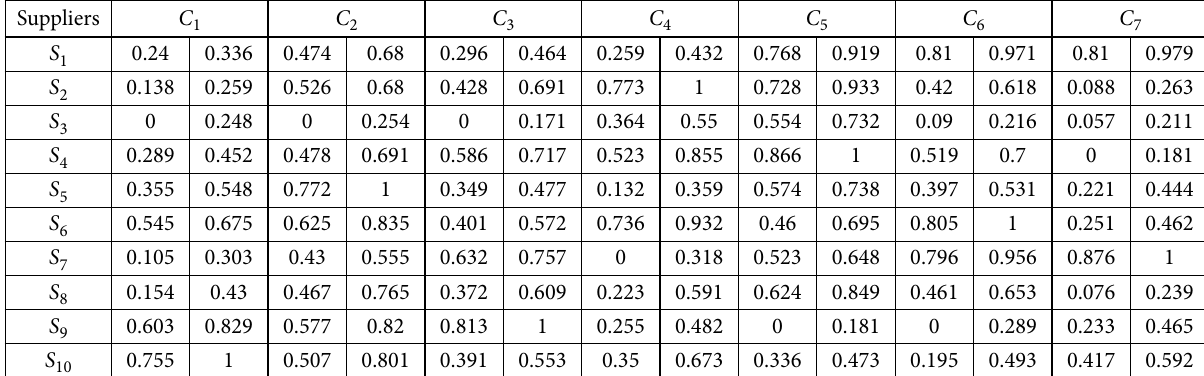
Table 10. The normalized grey decision matrix